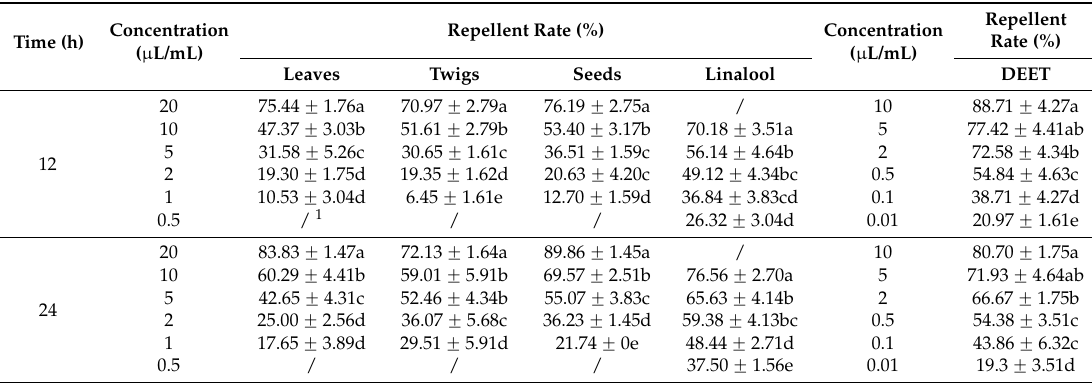
Table 3. Repellent rate for C. camphora essential oils and linalool against cotton aphids at different concentrations after 12 h and 24 h of